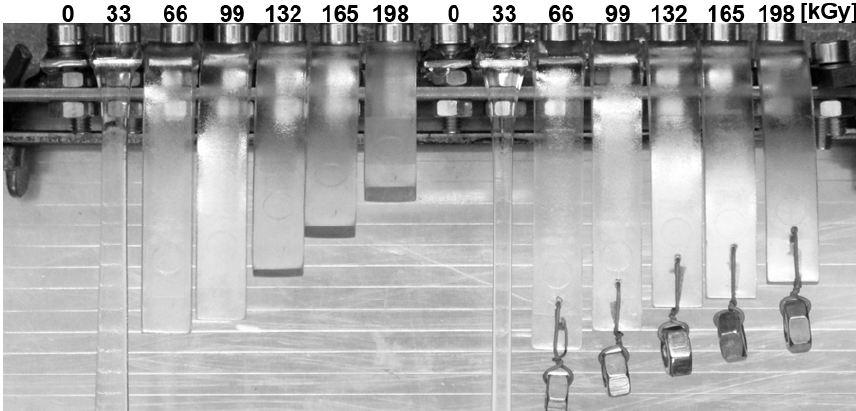
Figure 10. Visual observation after 1 h at 180 °C—Commodity polymers (HDPE).